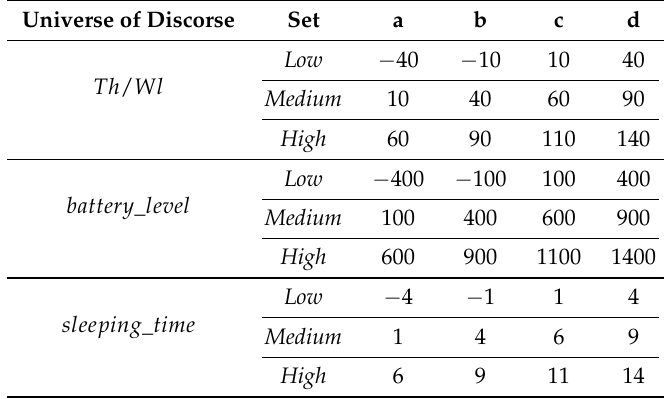
Figure 4. Trapezoidal membership functions of input and output parameters for the FLC: ( a ) Th / Wl ; ( b ) battery _ level ; ( c ) sleeping _ time . Table 1. Values of variables used in definition of trapezoidal membership